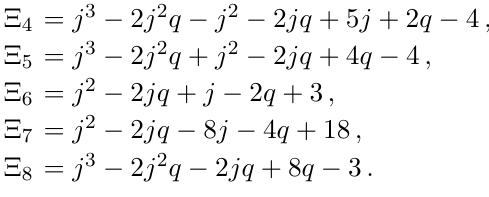
( QO ) T ( QO ) when QO h i = 0. We further C 6